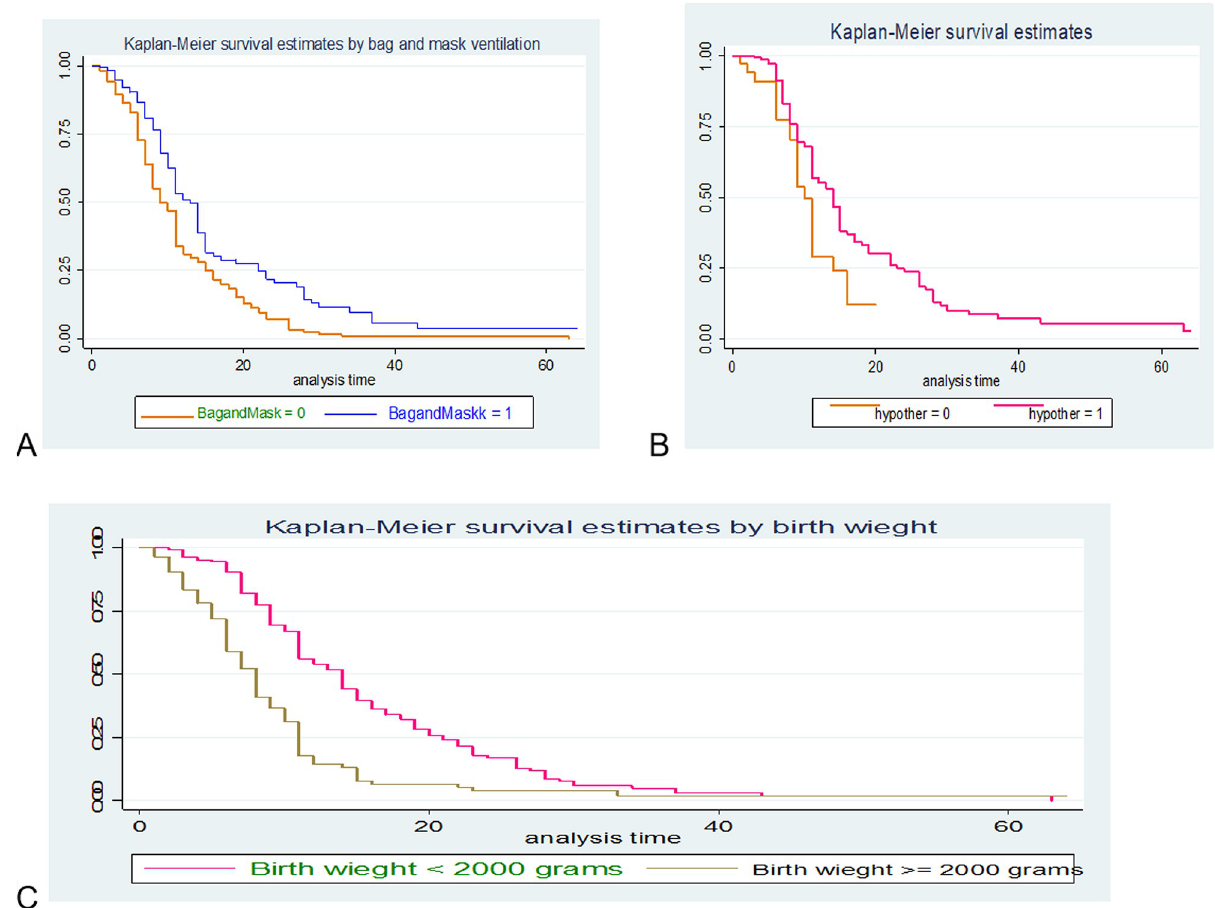
Fig 2. Kaplan-Meier curve of survival of preterm neonates with RDS admitted in NICU by bag & mask ventilation (A), hypothermia (B) and birth weight (C) at University of Gondar comprehensive specialized hospital from January 2016 to December 2018 (n = 386).